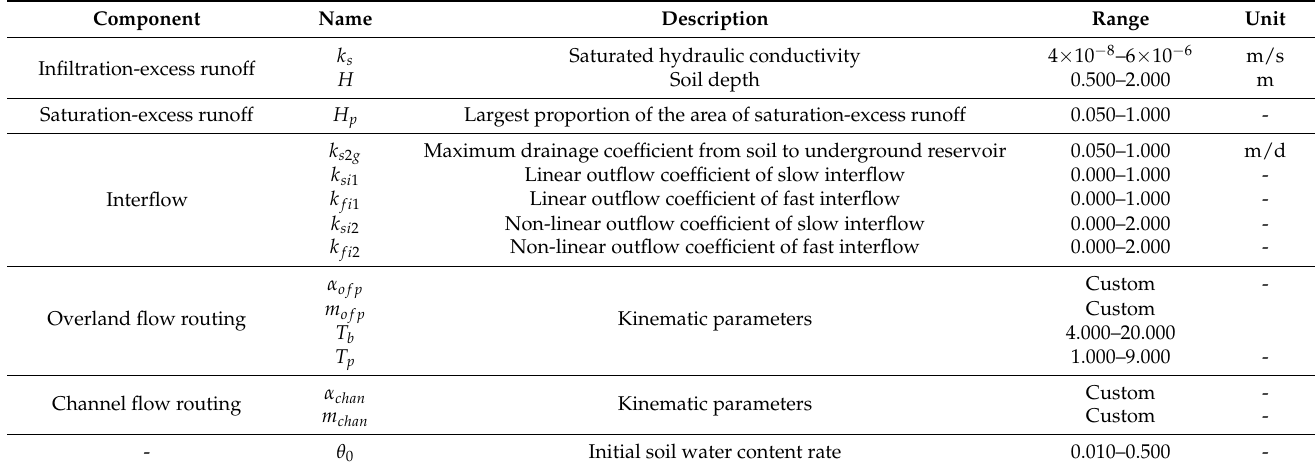
Table 5. The key parameters and ranges of the spatiotemporal variable source mixed runoff generation module-based surface flow and baseflow segmentation (SVSMRG-SBS) model.